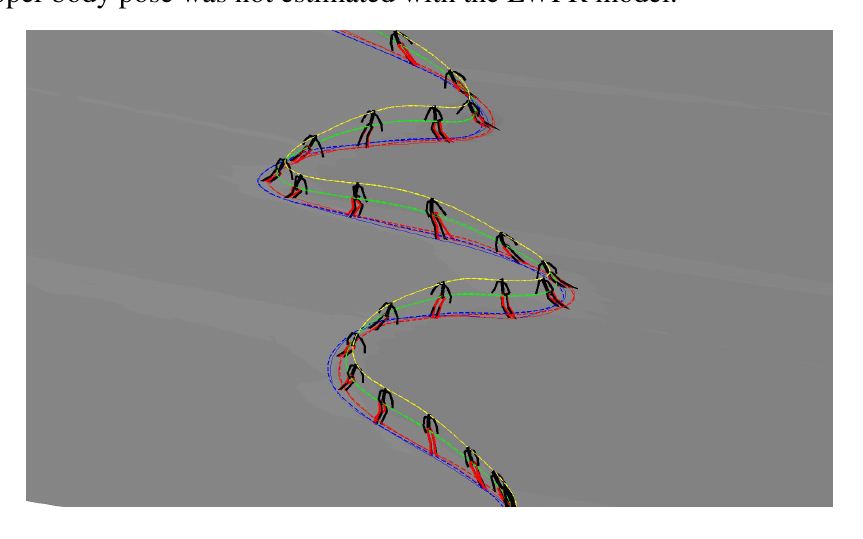
Figure 13. Mean errors of COM positions and skis positions, estimated by using LWPR for all 18 ski runs. The shadowed region denotes the standard